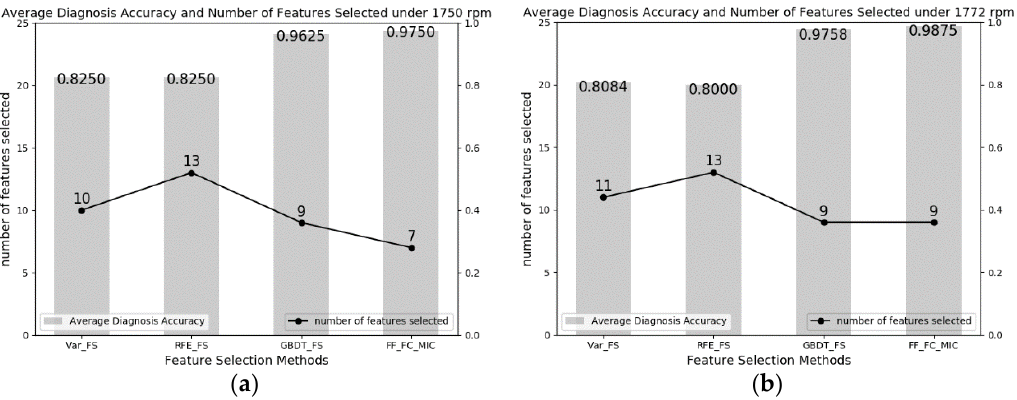
Figure 3. Average diagnosis accuracy of single fault and number of features selected at two motor speeds. ( a ) Average diagnosis accuracy and number of features selected at 1750 rpm; ( b ) average diagnosis accuracy and number of features selected at 1772 rpm.